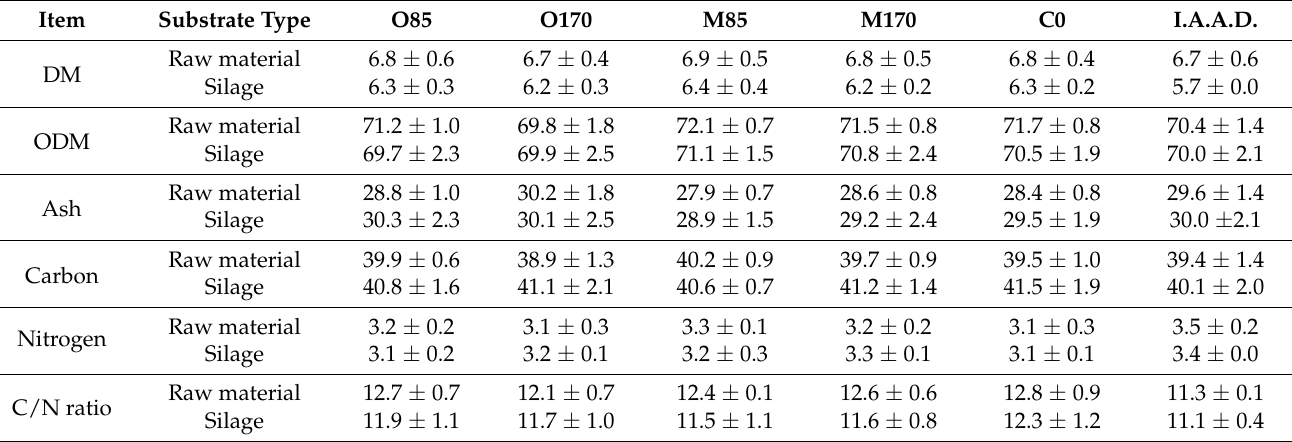
Table 8. Characteristic of digestate from raw material and ensiled Silphium perfoliatum